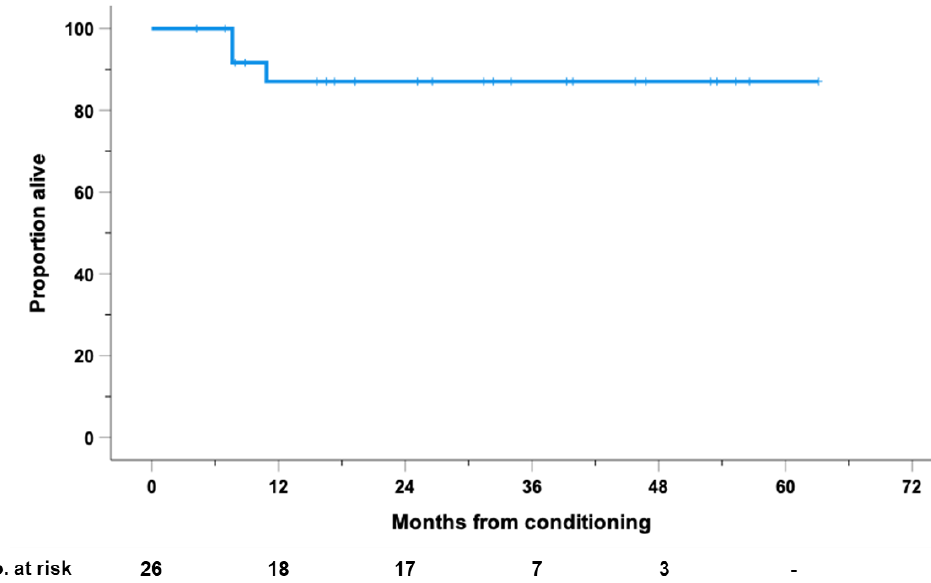
Figure 4. Overall survival (OS), calculated from the day of stem cell reinfusion, for the entire cohort of 26 high-risk patients with RR-HL who received consolidation with PD1-blockade after autologous stem cell transplantation (ASCT).